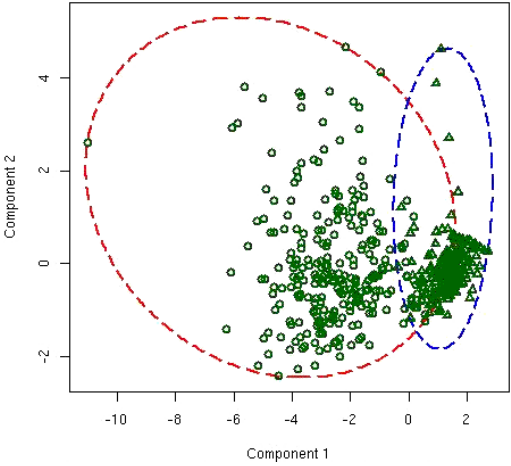
Fig. 23. Reallocated 699 Data by GKFCM.